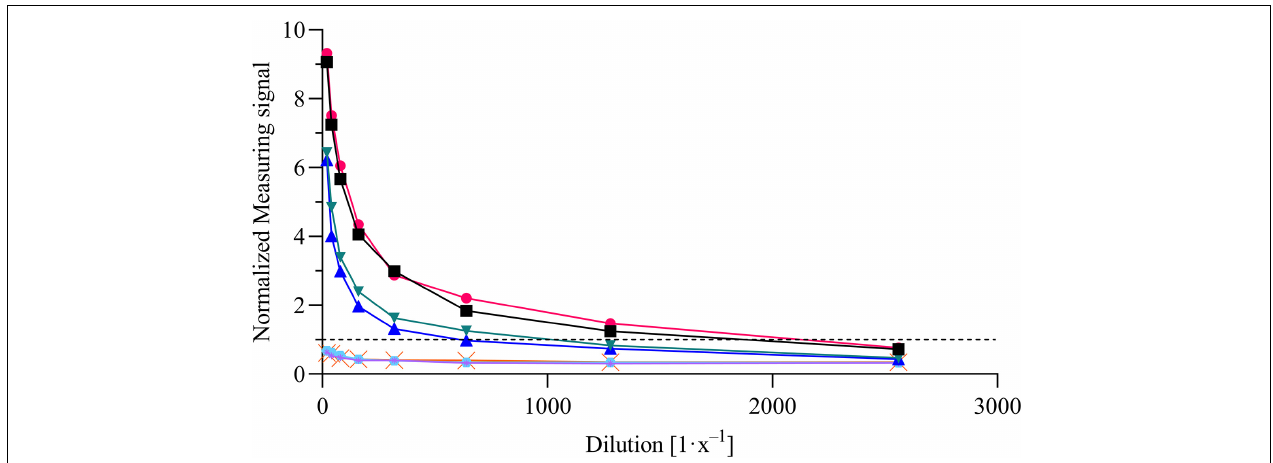
FIGURE 5 | Magnetic immunodetection-based SARS-CoV-2-specific antibody titer determination. Four previously tested positive and three negatively tested patient sera were analyzed in serial dilution starting from 20-fold up to 2560-fold dilution in phosphate-buffered saline (PBS). Samples were applied onto ready-to-use immunofiltration columns (RTU-IFCs) followed by application of biotinylated anti-human IgG-specific secondary antibody. Finally, magnetic particles functionalized with streptavidin were applied, and measuring signal was determined using portable frequency mixing magnetic detection (FMMD) readout device. Each data point represents n = 1. Dashed line represents the threshold.